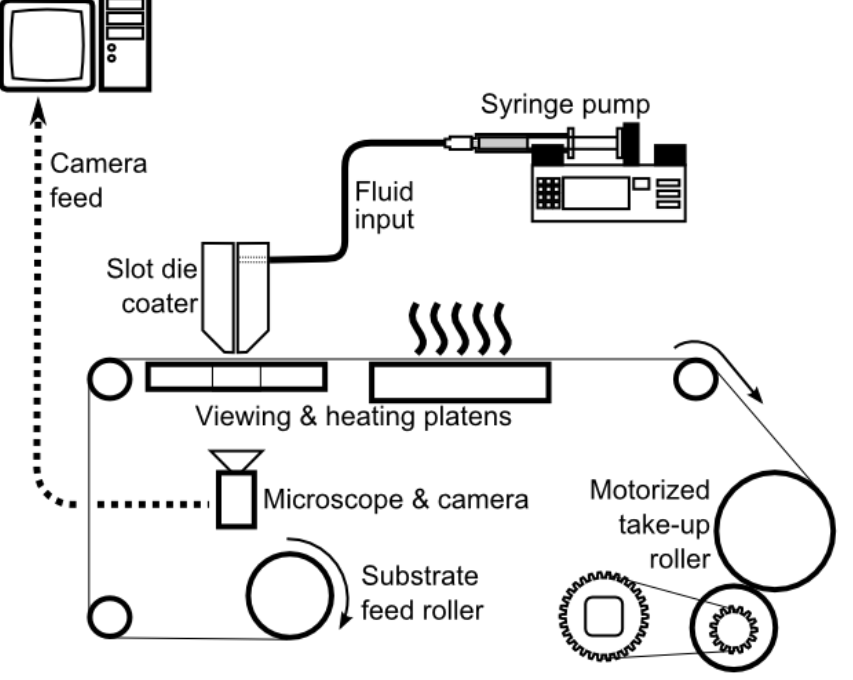
Figure 14. Schematic of a simple R2R experimental setup with a slot die coater. Reprinted with permission from [121]. Copyright 2020 John Wiley & Sons.